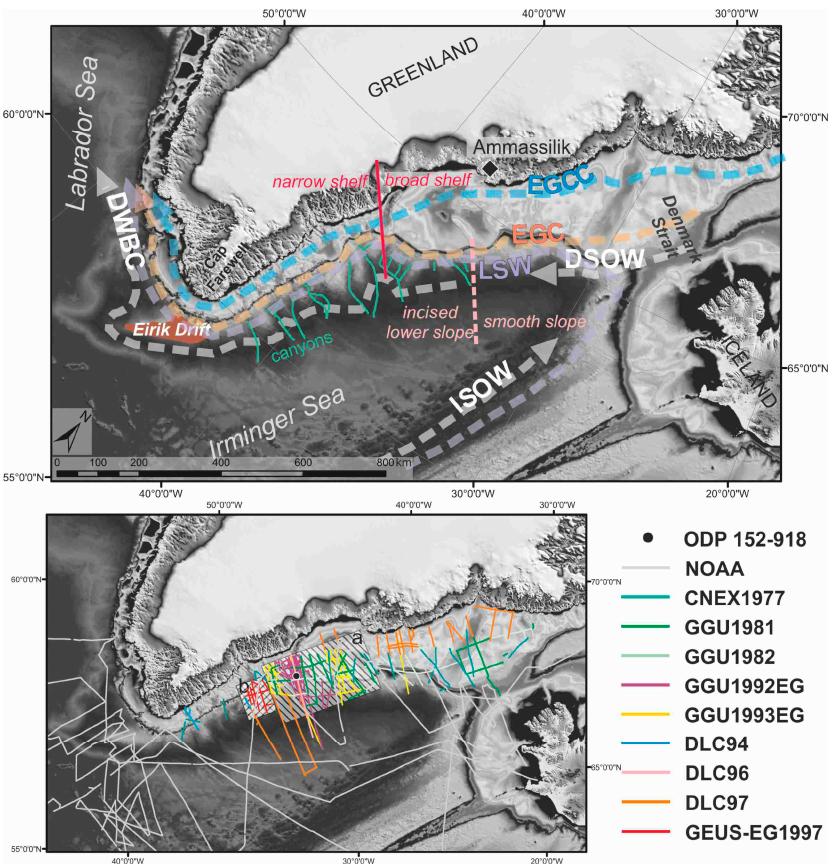
Figure 1. Extract of the International Bathymetric Chart of the Arctic Ocean (IBCAO) [18] showing the south-eastern margin of Greenland. Upper map: the bottom currents sweeping along the slopes of the Irminger Sea basin are indicated with dashed lines: DWBC = Deep Western Boundary Current; EGC = East Greenland Current; EGCC = East Greenland Coastal Current; LSW = Labrador Sea Water; ISOW = Iceland Scotland Overflow Water; and DSOW = Denmark Strait Overflow Water. Green lines indicate some of the canyons. Red line indicates the division between the broad and narrow shelf, and pink dash line indicates the division between the smooth slope and the incised lower slope. Lower map: location of the different seismic lines used for this study and the location of the ODP Leg 152 Site 918